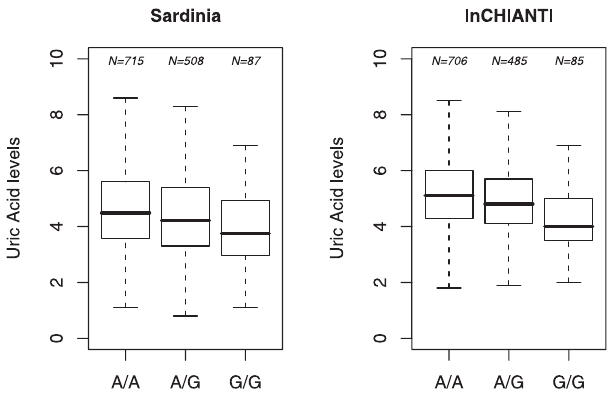
Figure 2. Boxplot for UA Levels Correlated with rs6855911 Genotypes in Sardinian and InCHIANTI Population Cohorts Standard boxplots are drawn with min, 0.25 quantile; median, 0.75 quantile; and 0.75 quantile þ 1.5*IQR for the levels of UA (mg/dl). To increase readability, outliers were removed from the boxplots, but they were taken into account when estimating the parameters. Sample size for each genotype class is also annotated. doi:10.1371/journal.pgen.0030194.g002 PLoS Genetics |